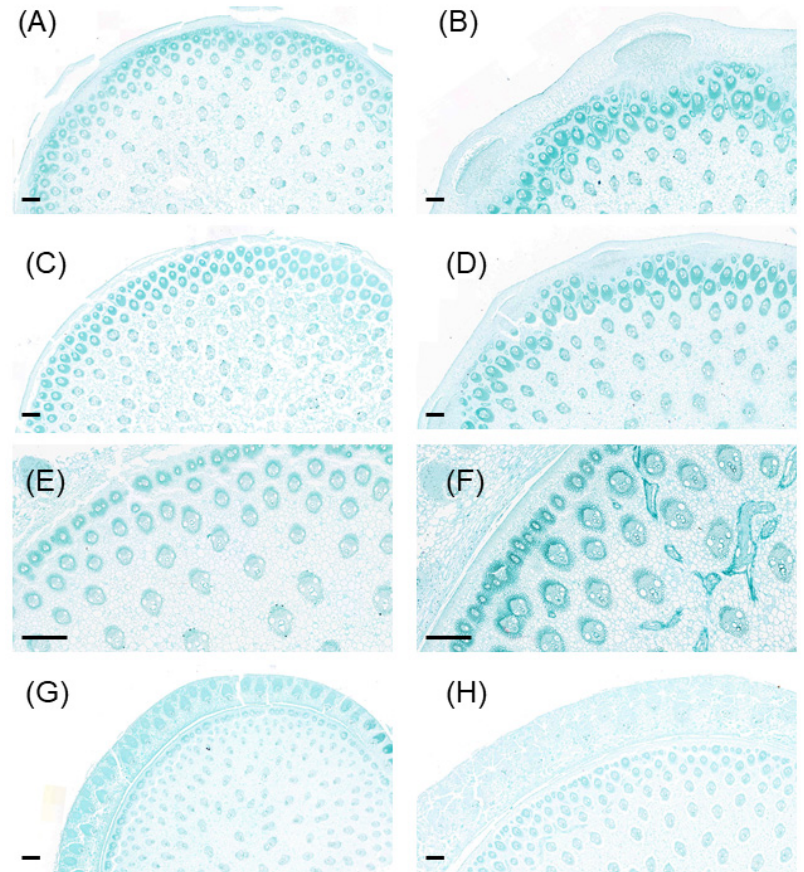
Figure 5. Transverse sections show the stem base node (Node 1, ( A , B )), two nodes above stem base (( C , D ) for Node 2, and ( E , F ) for Node 3, respectively), and Node 8 ( G , H ) in maize plants under low ( A , C , E , G ) and medium N ( B , D , F , H ) availability at 62 days after sowing. Scale bars represent 500 μ m.